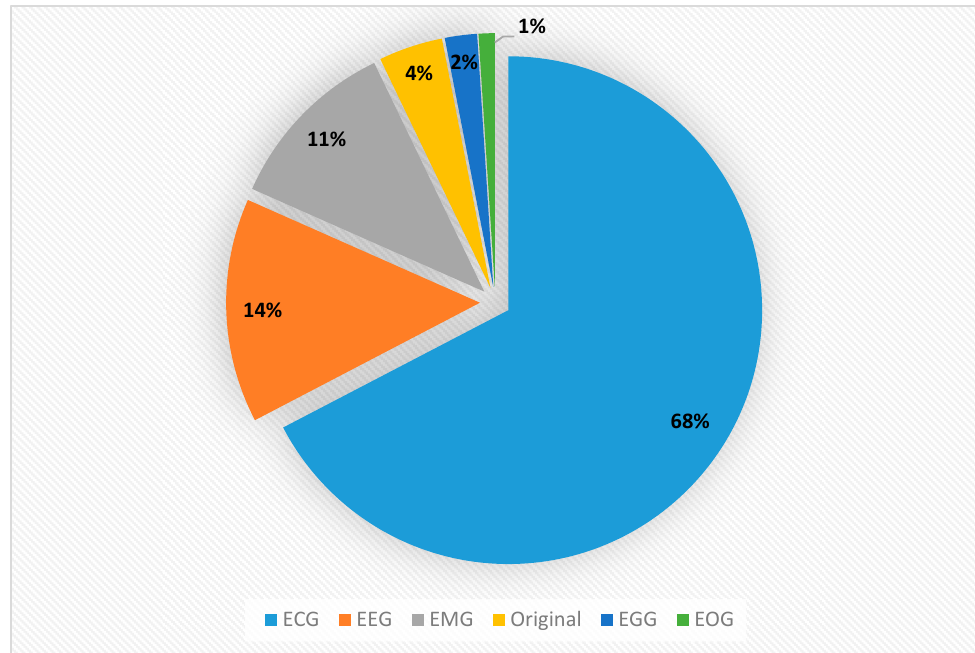
Figure 14. Application of analog front-ends.